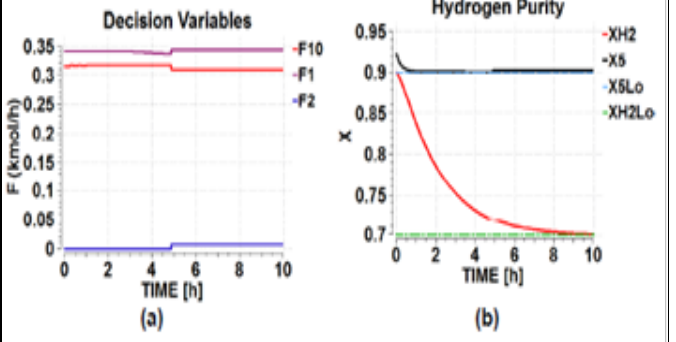
Figure 12: (a) Manipulated and (b) constrained variables. Source: Authors, (2018).